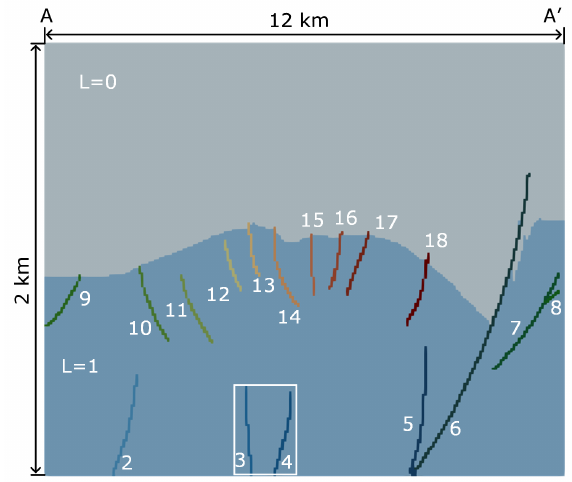
Figure 3. Model domain and geometry of the interpreted seismic transect A-A’ modified after [45] (cf. Figure 2a,b). The lithology markers (L) represent the sediments of the Iperk–Mackenzie Bay (0) and Kugmallit–Richards Sequences (1). The 17 faults considered in the model are identified by the lithology markers 2 to 18. Faults 3 and 4 (located within the white rectangle) are the sources for the dissolved CH 4 -rich fluid flowing into the modeling